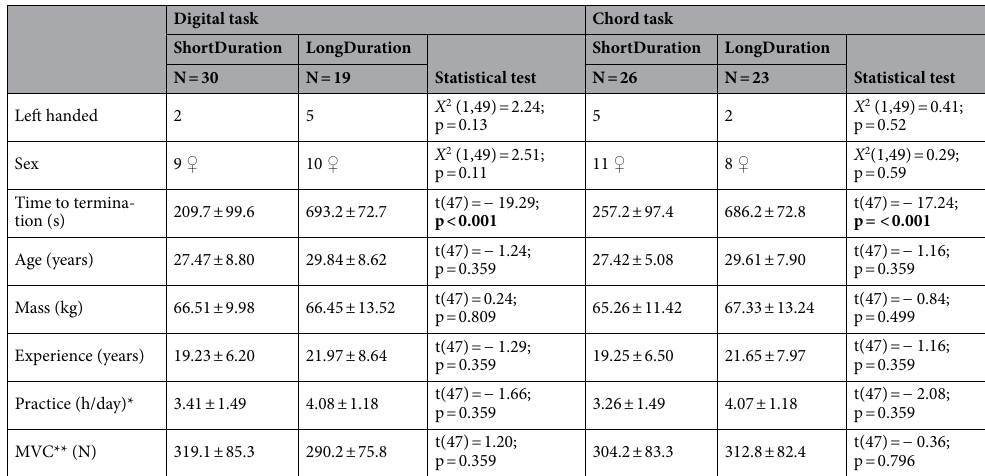
Table 1. Demographic data of participants (mean ± SD). *in the past year. ** MVC maximal voluntary contraction. Bold values highlight significant differences between groups (α = 0.05).